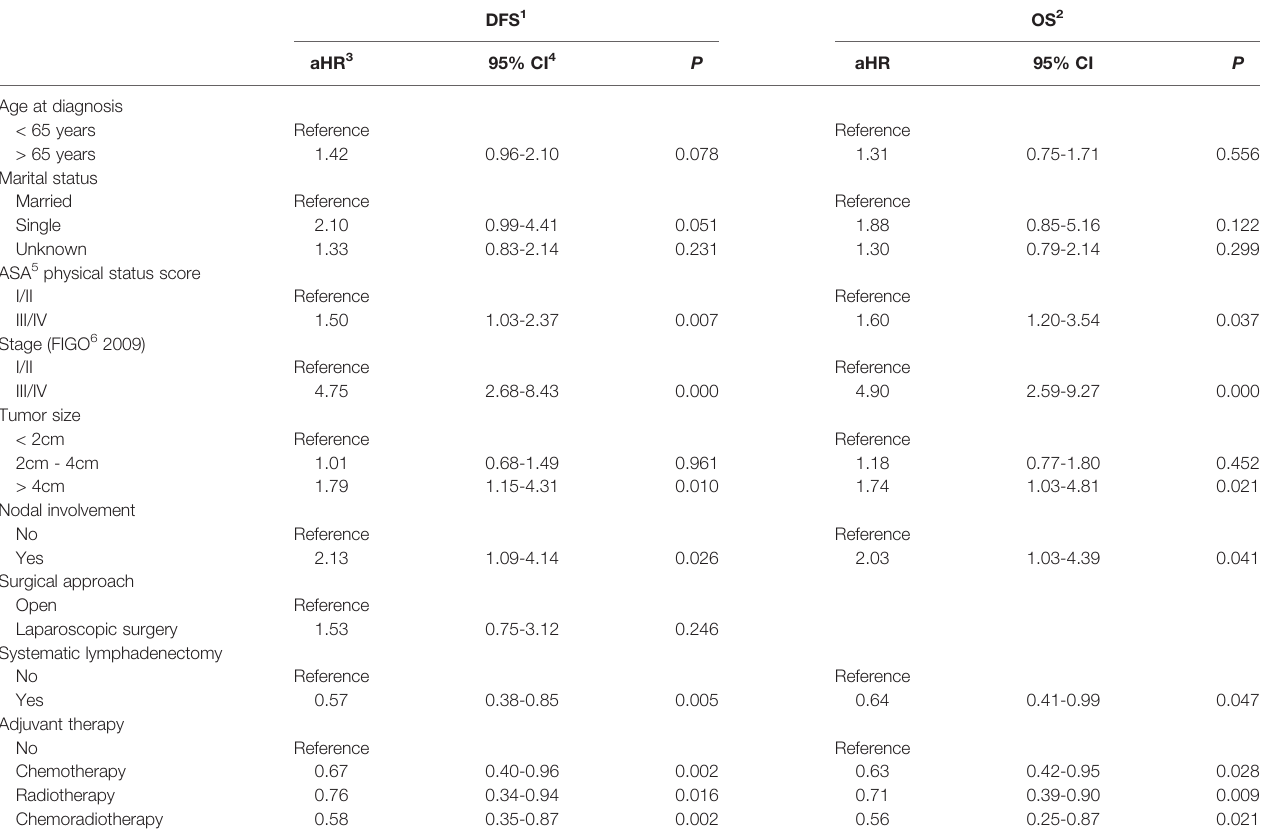
TABLE 3 | Multivariate analyses of prognostic factor for DFS and OS in women with apparent early-stage clear cell carcinoma of the